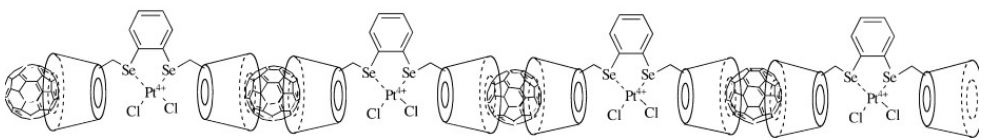
Figure 6. Supramolecular fullerene polymer mediated by metallobridged β -cyclodextrins, from Liu et al.